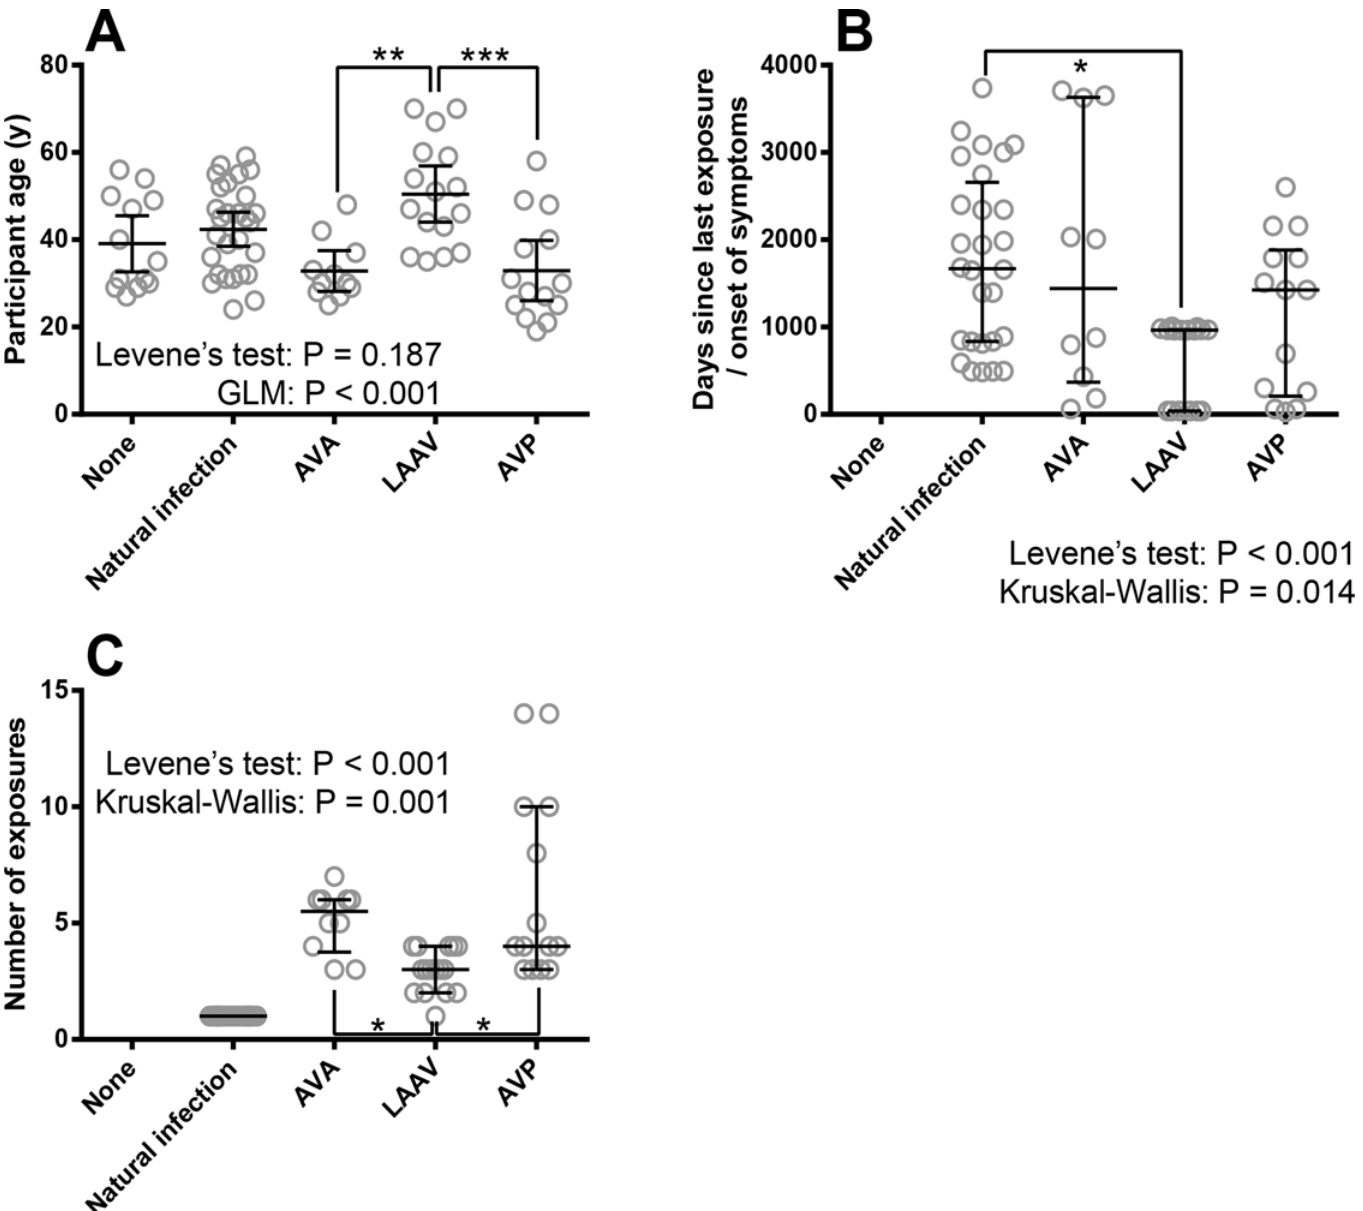
Fig 1. The characteristics of individuals enrolled into this study including: age, number of exposures to B . anthracis antigens and time since exposure in relation to the type of exposure to B . anthracis antigens. Panel A shows the distribution of age across groups in study including individuals with no history of Anthrax, recent Anthrax infection, or one of three different vaccines. Each symbol denotes a single participant, the line is the mean and the error bars 95% Confidence Intervals. Statistical analysis is shown where Levene ’ s test validated GLM has been performed with Bonferroni ’ s post-tests. Panel B shows the distribution of time since exposure to vaccine or onset of anthrax symptoms across groups in the study. Each symbol denotes a single participant, the line is the median and the error bars the quartile range. The data were analysed by Kruskal-Wallis test (excluding na ï ve controls), which indicated differences between groups with Dunn ’ s individual comparisons. Panel C shows the distribution of number of anthrax-based immunological stimuli (doses) across groups in the study including percent people who had had Anthrax infection, or one of three different vaccines. Each symbol denotes a single participant, the line is the median and the error bars the quartile range. The data (excluding na ï ve and naturally infected controls) were analysed by Kruskal- Wallis test, which indicated differences between groups with Dunn ’ s individual comparisons. Significance markers indicate either P-values associated with either Bonferroni ’ s (For GLM) or Dunn ’ s (for Kruskal-Wallis) multiple comparisons where * indicates P < 0.05, ** indicates P < 0.01 and *** indicates P <